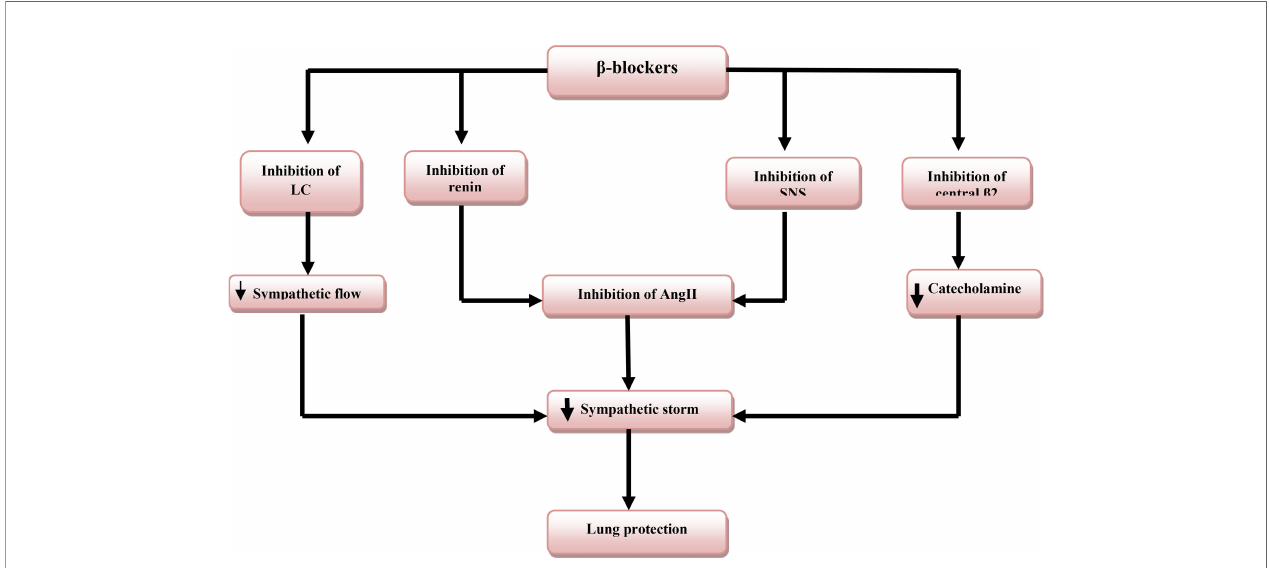
FIGURE 4 | Role of b -blockers in lung protection: b -blockers inhibit sympathetic nervous system (SNS), renin release, locus coeruleus (LC) activity, and central presynaptic b 2 receptors that decrease the release of catecholamine and angiotensin II (AngII) with subsequent inhibition of sympathetic storm and lung